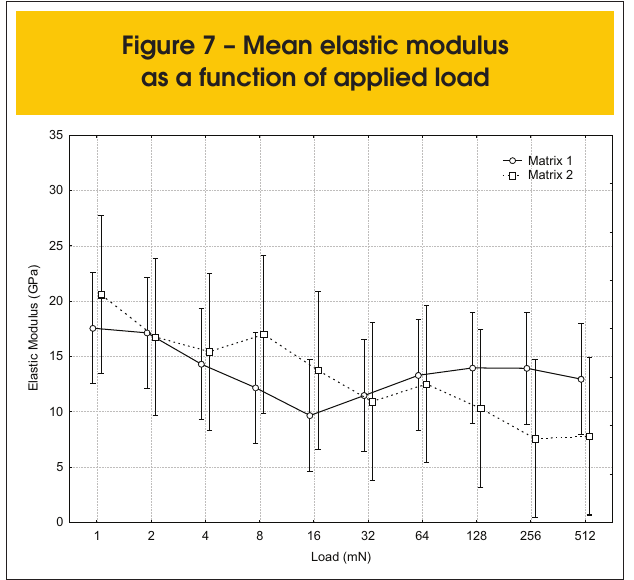
Figure 7 – Mean elastic modulus as a function of applied load